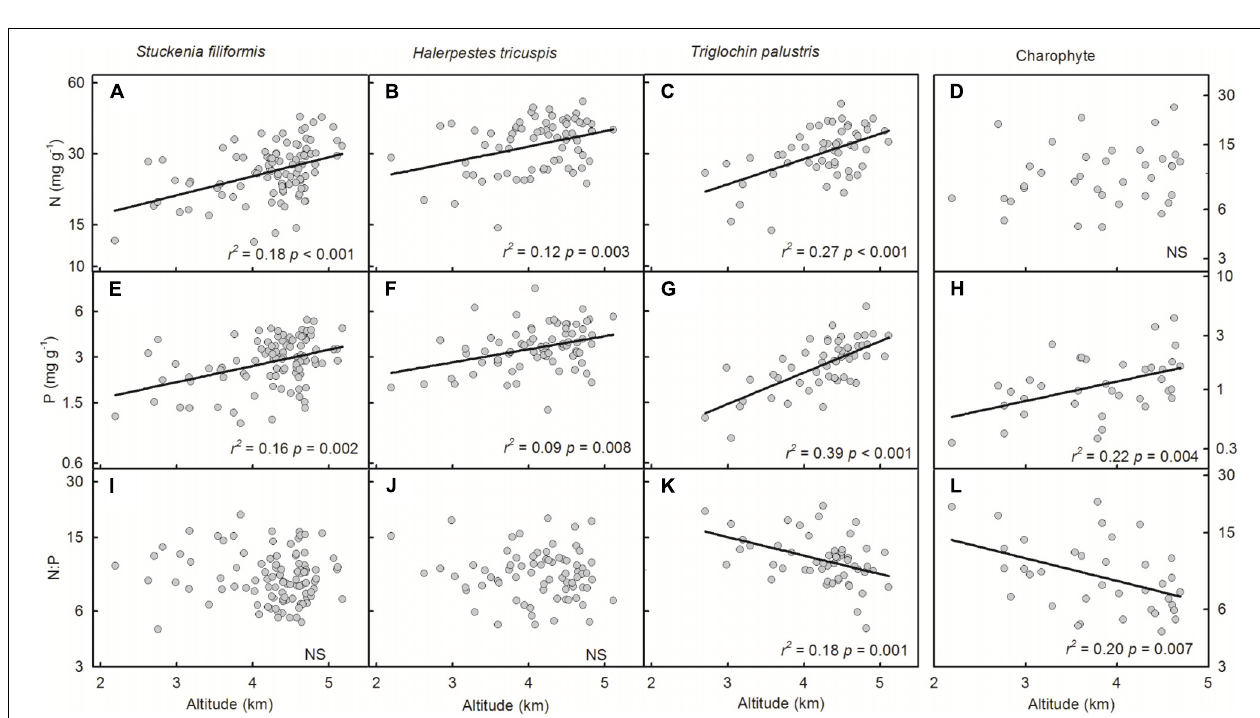
FIGURE 5 | Trends of plant N and P concentrations and N:P ratios along altitudinal gradients (A–L) . The p -value in each panel was the original one of each test if it was smaller than the corrected one obtained by Holm’s Sequential Bonferroni Procedure. If not, the test was non-significant (NS).